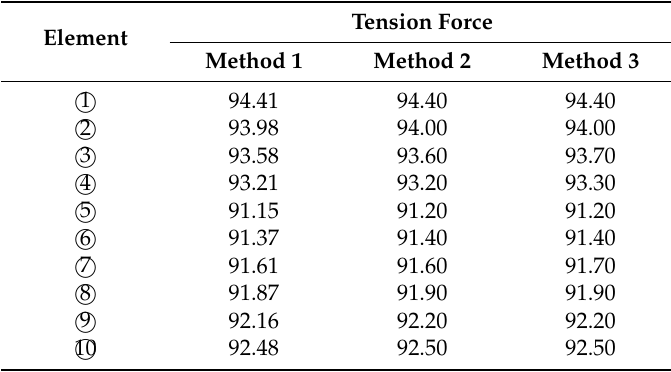
Table 7. Tension force of cable segments under applied load (unit: kN).